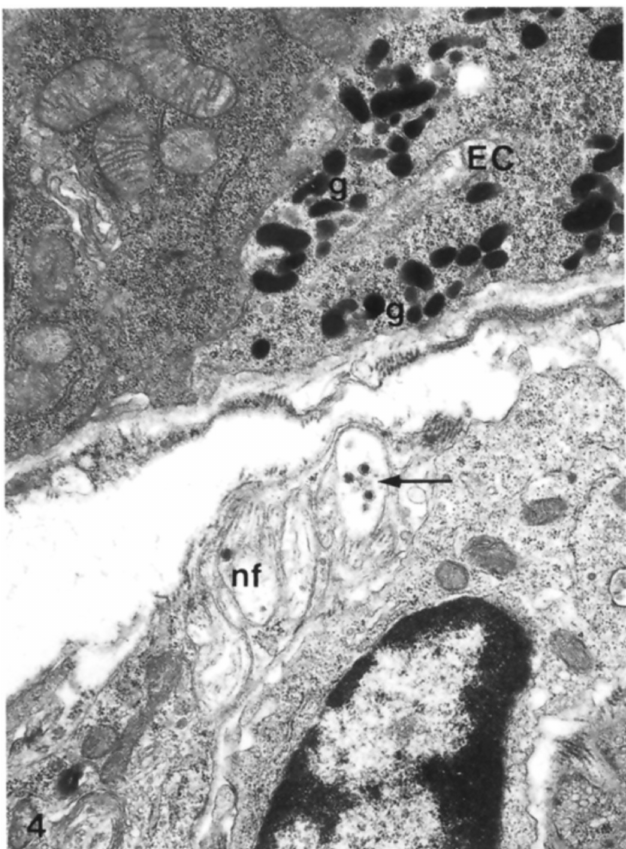
Figure 9. Base of an enterochromaffin cell fixed in glutaraldehyde and osmium tetroxide in which it is possible to see the presence of secretory granules containing clear and dense-cored vesicles, close to nonmyelinated nerve fibers. EC: enterochromaffin cell; nf: nonmyelinated nerve fibers; g: secretory granules; black arrows indicate dense-cored vesicles. X25.500. The Figure is obtained from Wade and Westfall, (1985). Reprinted by permission from Springer Nature Customer Service Centre GmbH: Springer Nature, Cell and Tissue Research (License Number 5232430326152, 19 January 2022)